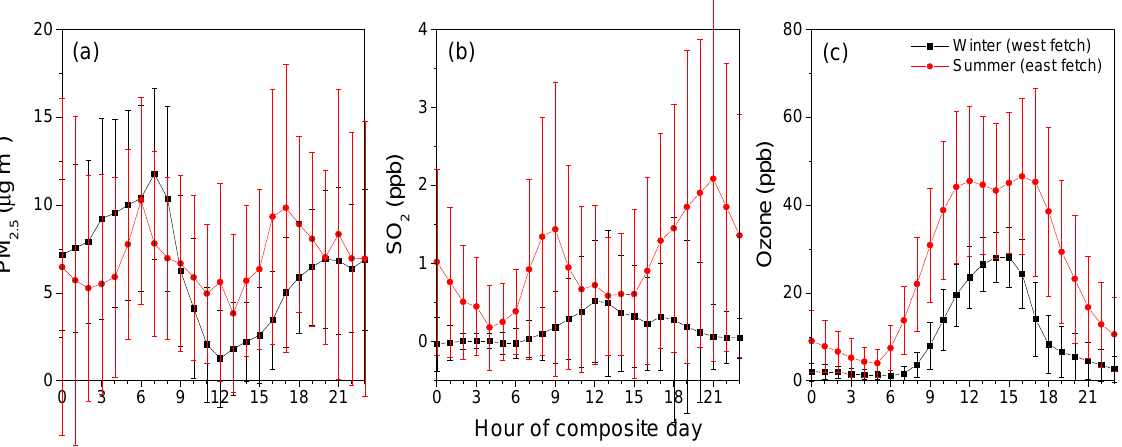
Figure 12. Comparison of hourly mean diurnal composites under “stable” atmospheric conditions in winter and summer for (a) PM 2 . 5 , (b) SO 2 , and (c) O 3 ; whiskers represent ± 1 σ . Note difference in time axis cf. Fig.